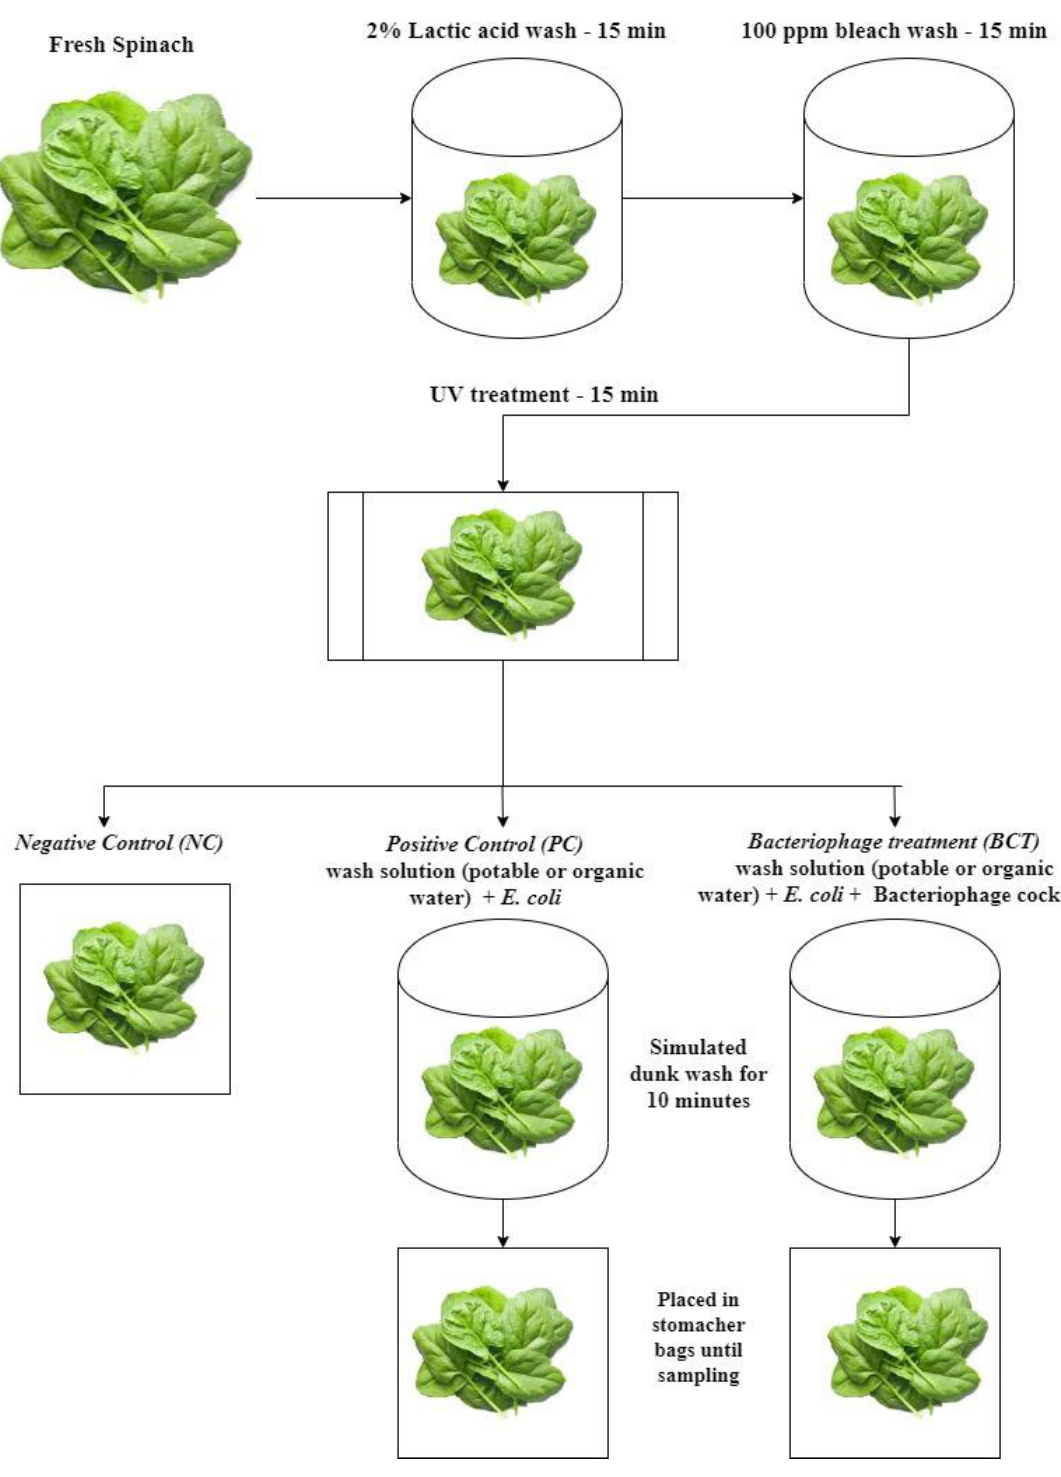
Figure 1. Schematic flow of initial produce rinse and dunk wash of spinach leaves.